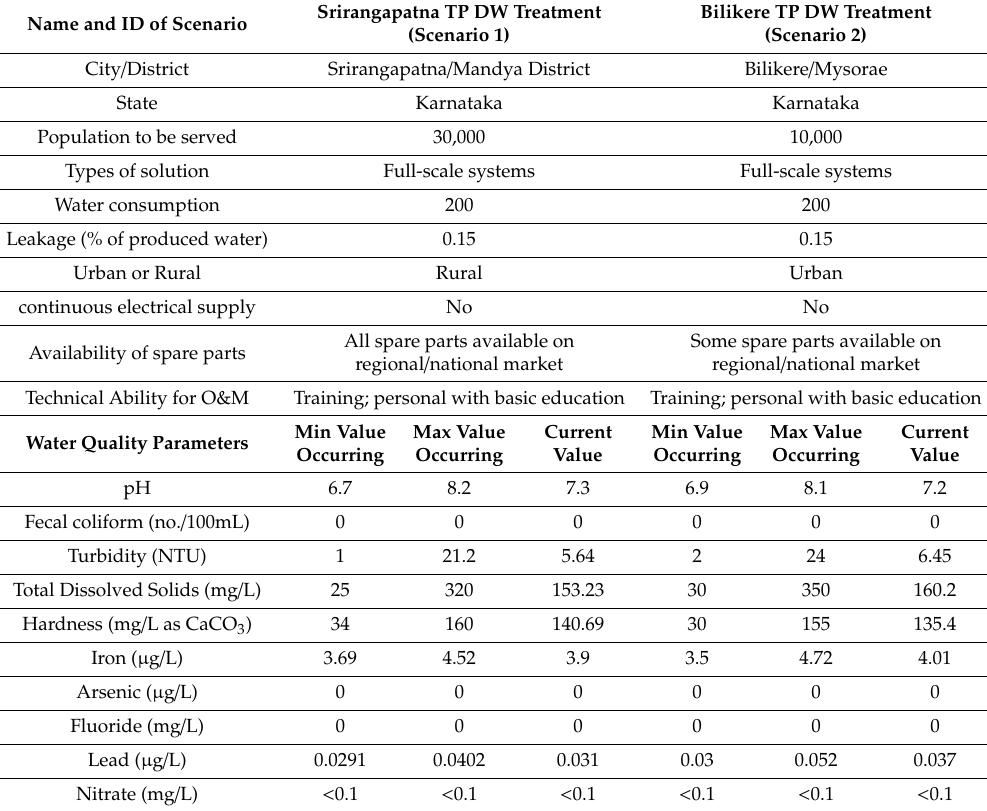
Table 2. Main information / assumption on the centralized